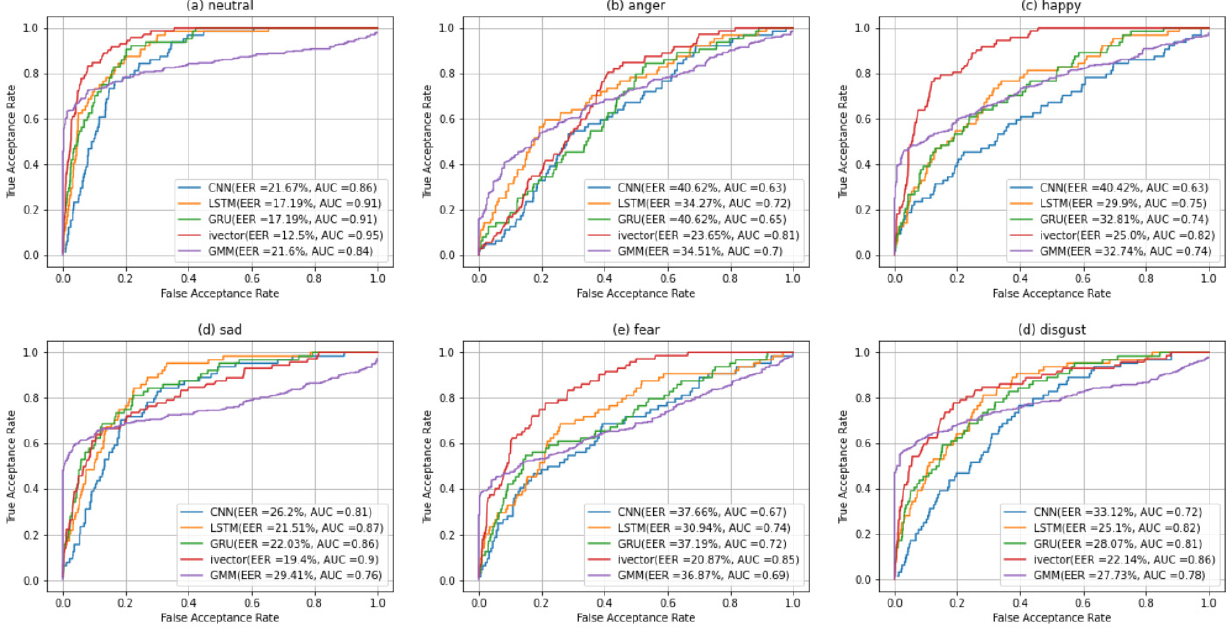
Figure 8. ROC plots using CREMA database based on CNN, LSTM, GRU, i vector, and GMM.